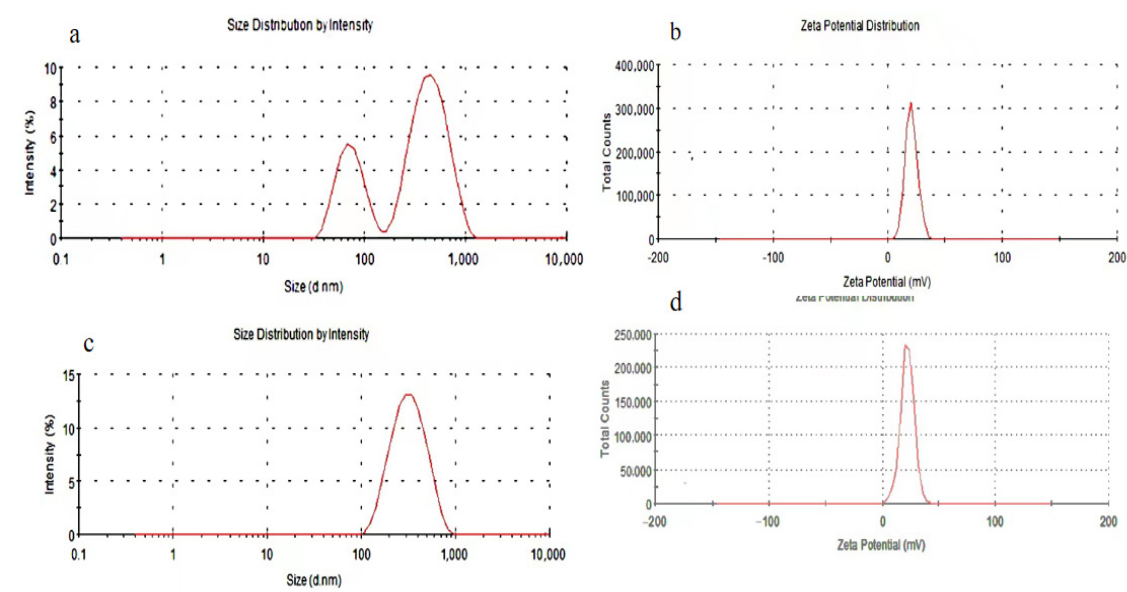
Figure 4. Particle size distribution and Zeta potential distribution of 6- β -CD-N-ODMA ( a , b ) and PTX/6- β -CD-N-ODMA ( c , d ).